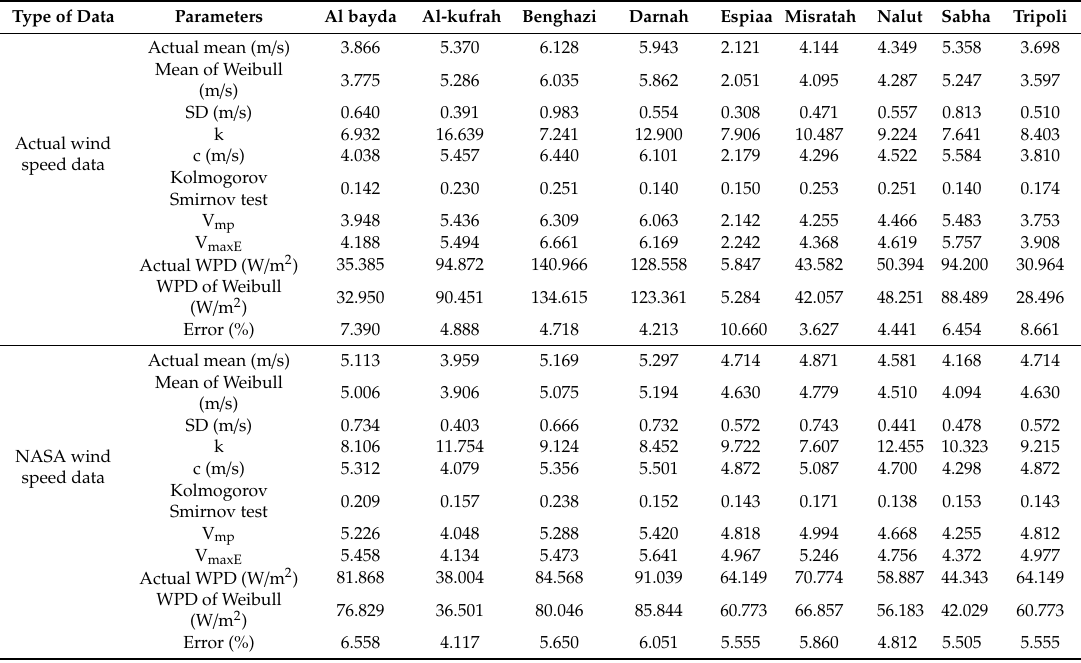
Table 6. Weibull parameters, most probable wind speed and maximum energy carrying wind speed values, and wind power density over the investigation period at a 10-m